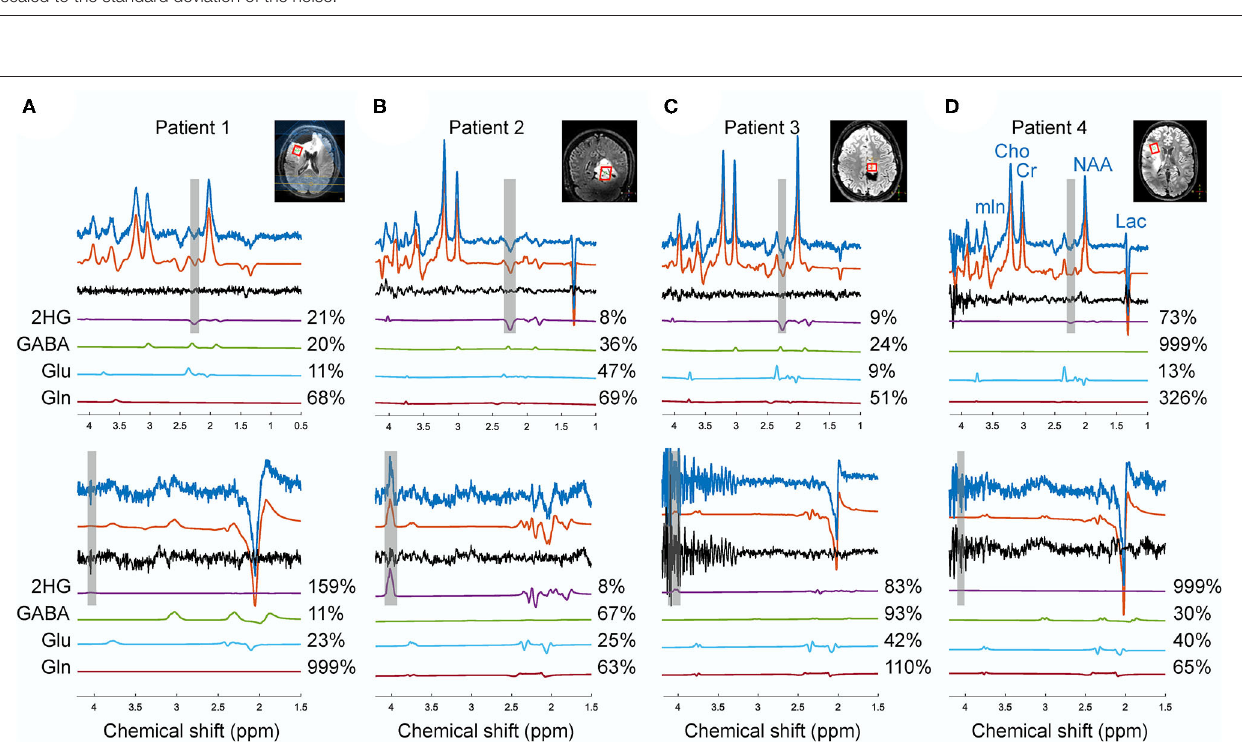
FIGURE 6 | The spectra from sLASER (upper spectra) and MEGA-sLASER (lower spectra) acquired in patients 1 (A) , 2 (B) , 3 (C) , 4 (D) with histologically confirmed IDH1-mutated glioma. The frequency ranges of 2HG γ (2.25 ppm) and α (4.02 ppm) signals are shaded in gray. The voxel sizes for patients 1, 2, 3, and 4 were 8, 9.6, 4.98, and 8 cm 3 ,